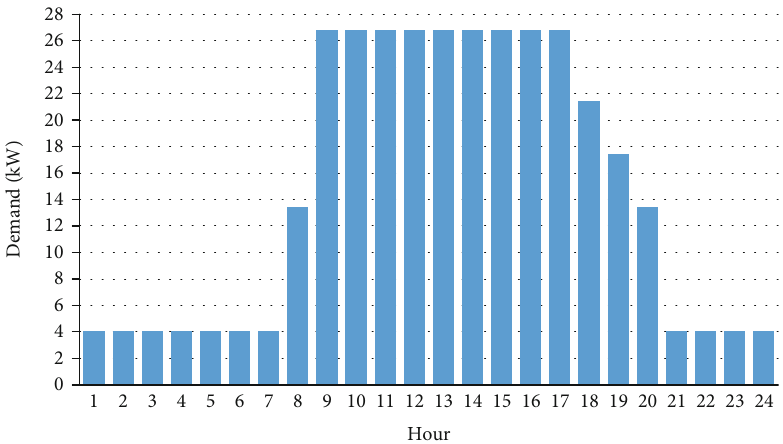
Figure 4: Daily energy demand for the proposed